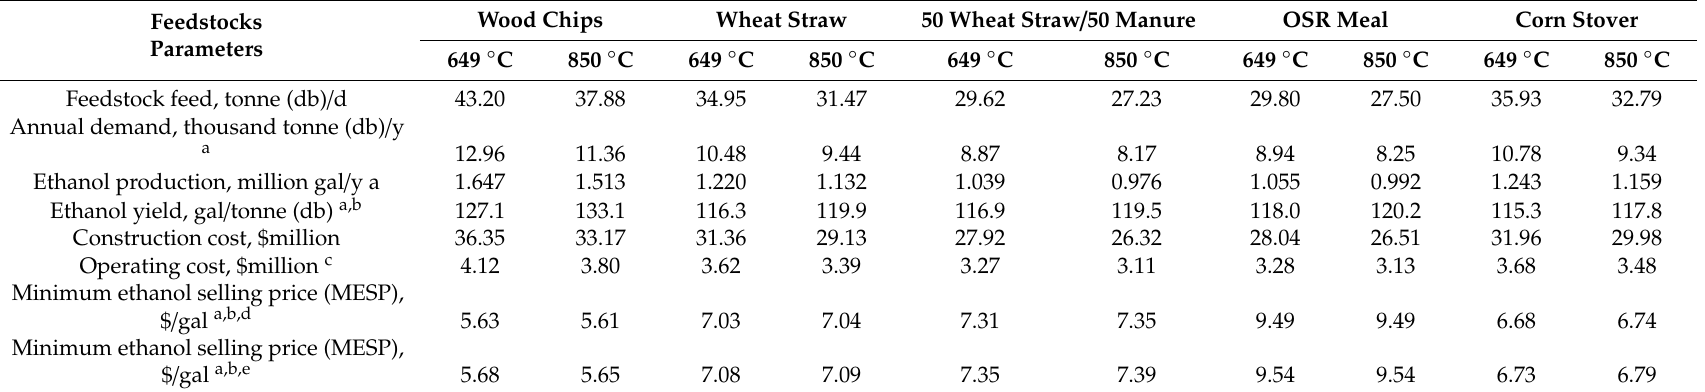
Table 6. Case 2—Comparison of feedstock feed rate, syngas and ethanol yield and ethanol selling prices from gasification and syngas fermentation of 1 kg / s syngas from 5 feedstocks in a 1–2 million gallons per year (MGY) ethanol